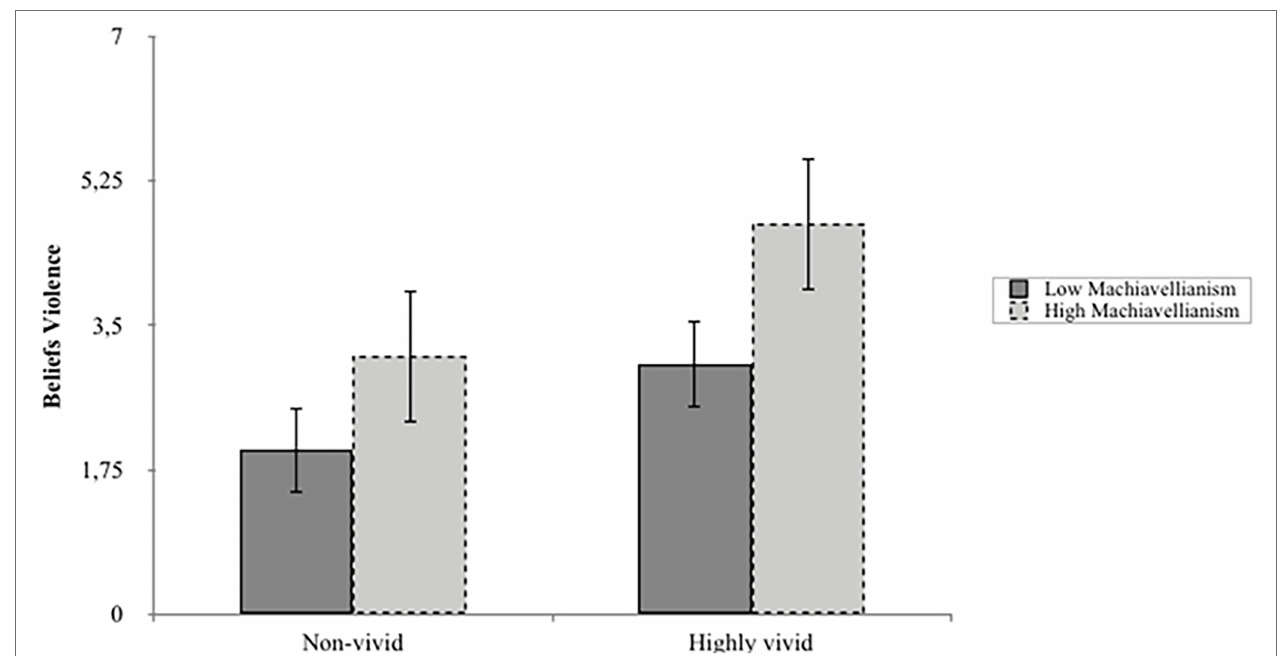
FIGURE 3 | The moderating role of Machiavellianism by narrative vividness on HLA Use of Violence.